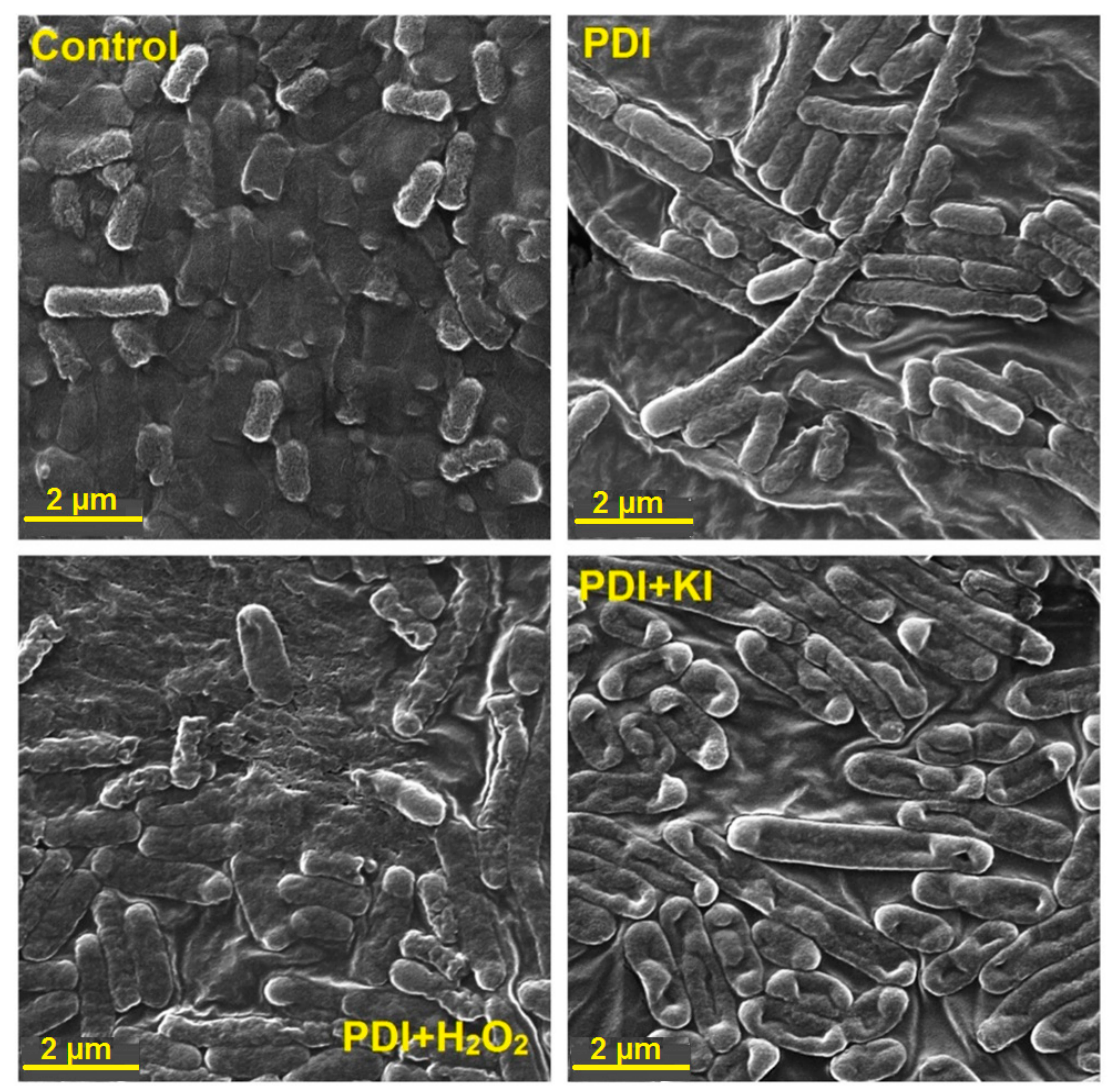
Figure 10. SEM images of Escherichia coli before PDI treatment (control) and bacterial cell debris after different PDI procedures (2 h incubation, 10 J/cm 2 , 420 ± 20 nm LED light, material concentration of 0.5 g/L with addition of 100 mM H 2 O 2 or 100 mM KI).